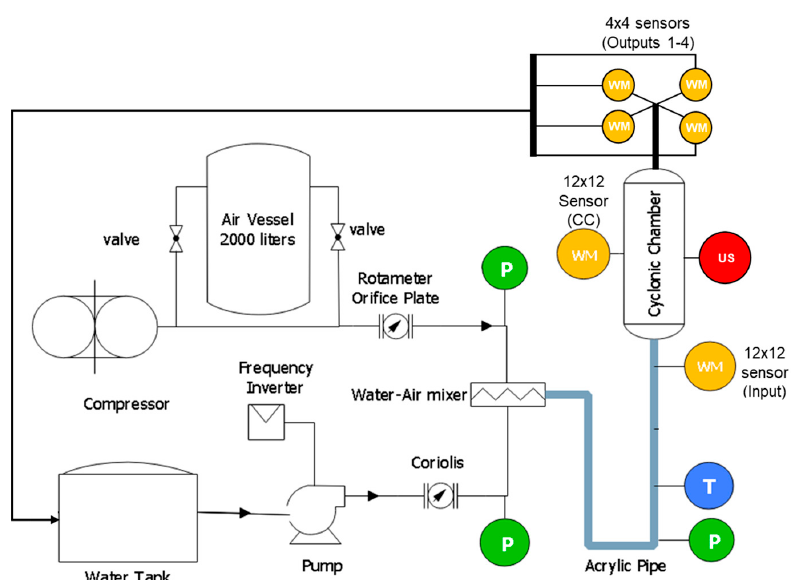
Figure 2. Schematic representation of the measurement plant with the wire-mesh sensors (WMS), ultrasound (US), pressure and temperature sensors (P) and (T).